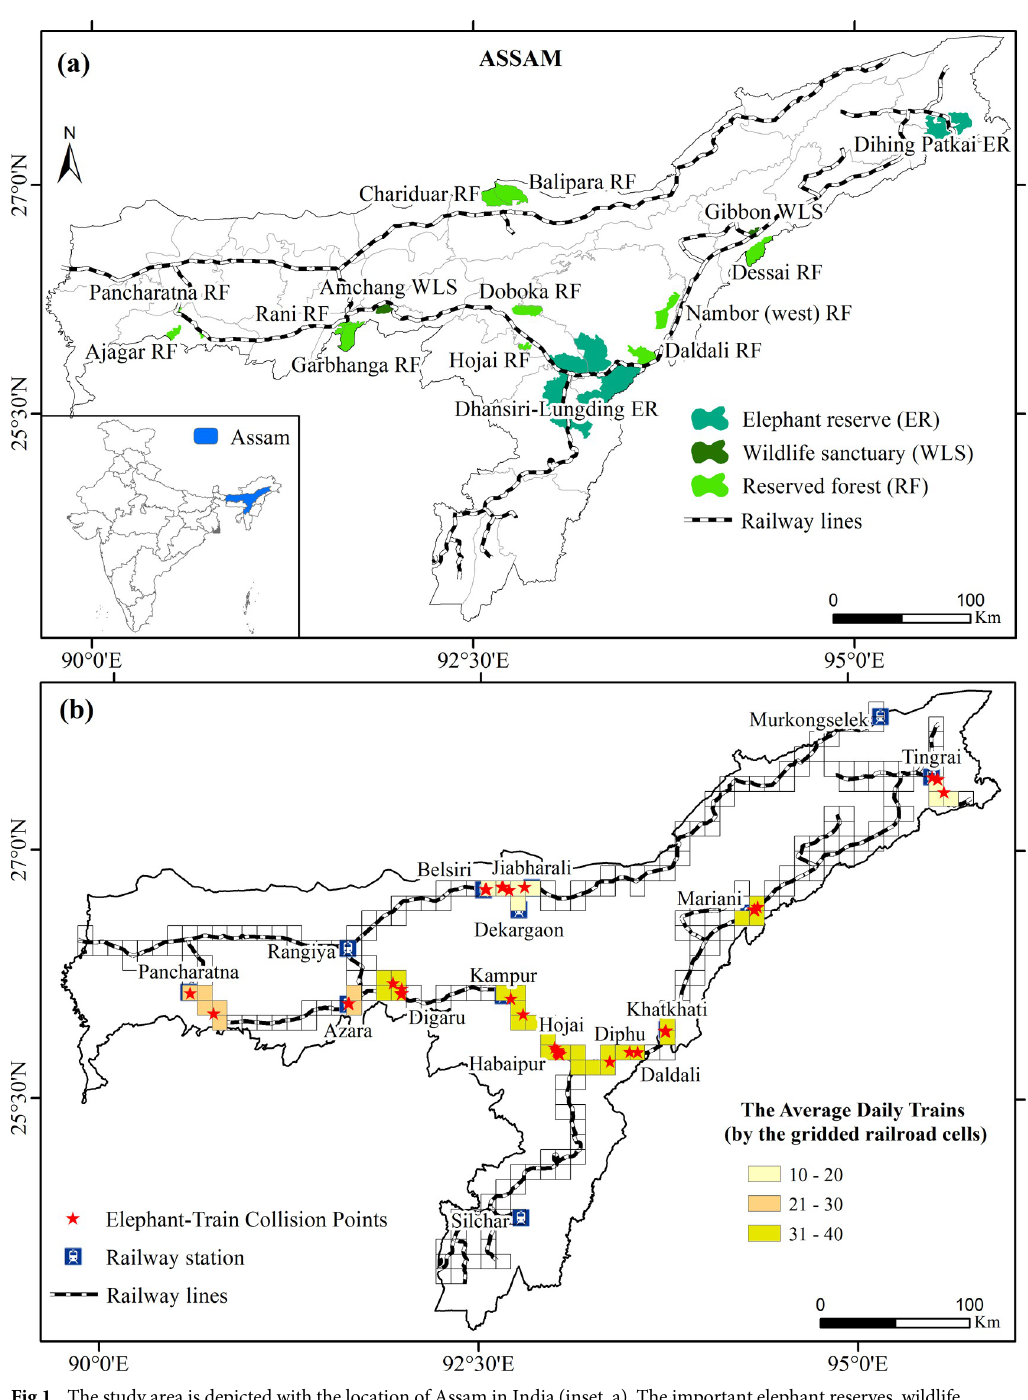
Fig 1. The study area is depicted with the location of Assam in India (inset, a). The important elephant reserves, wildlife sanctuaries and reserved forests are shown along with the railway segments (a). The elephant train collision points and the average daily trains per gridded railroad cells are shown in